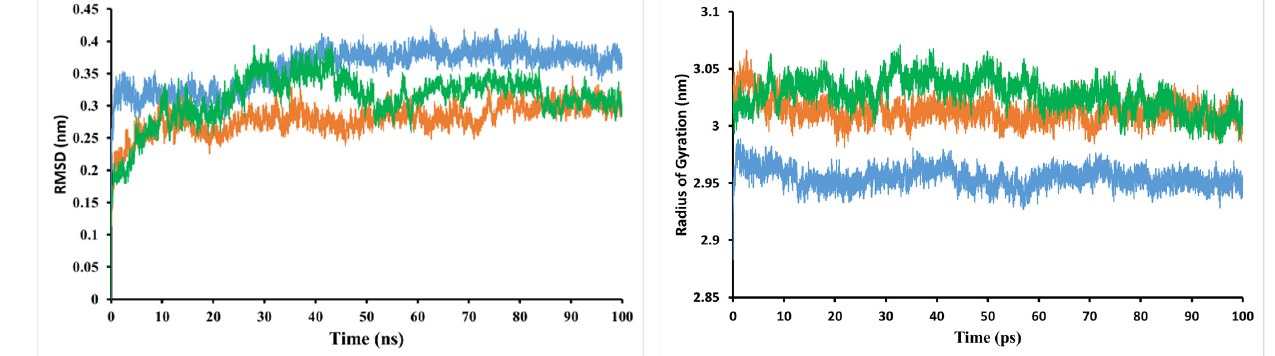
Figure 3. Root-mean-square deviation (RMSD) of the backbone atoms and radius of gyration (Rg) from the starting structure for trans − 3 − O − p − hydroxycinnamoyl ursolic acid (in blue), 5,7,4 ′− trihydroxyisoflavone 7 − O − β − D − apiofuranosyl − (1 → 6) − β − D − glucopyranoside (in green), and the reference compound (in orange) with the PI3K/mTOR protein throughout 100 ns MD simulations.